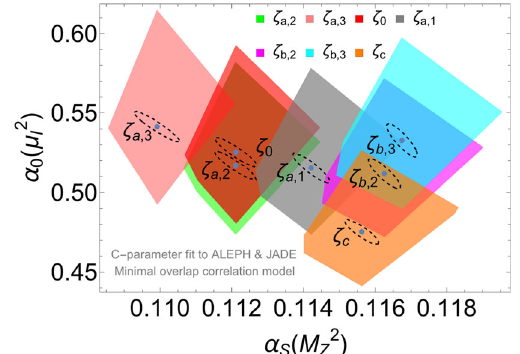
Fig. 2 Fit results for α s and α 0 for different models of ζ( C ) . The points indicate the fit corresponding to the central setup of scales and parameters for a given model. The ellipses show the Δχ 2 = 1 contours associated with the experimental uncertainty. The shaded areas repre- sentthetheoryuncertaintiesduetothevariationofadditionaltheoretical parameters as described in the text